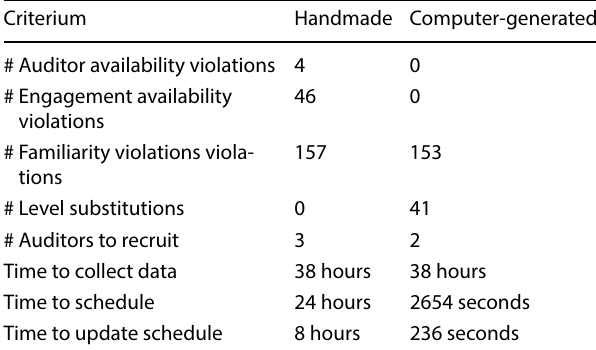
Table 1 Empirical comparison of a handmade schedule to the opti- mized schedule. When a handmade schedule takes 24 hours to